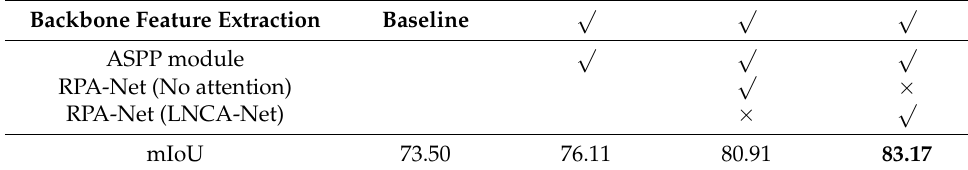
Table 2. Results of ablation experiments using the same dataset (BDCI 2017), where bold numbers √ indicate the highest mIoU, “ ” indicates that the leftmost component is used in the model, and “ × ” indicates that the leftmost component is removed. In each column, the last number represents the mIoU obtained using the corresponding